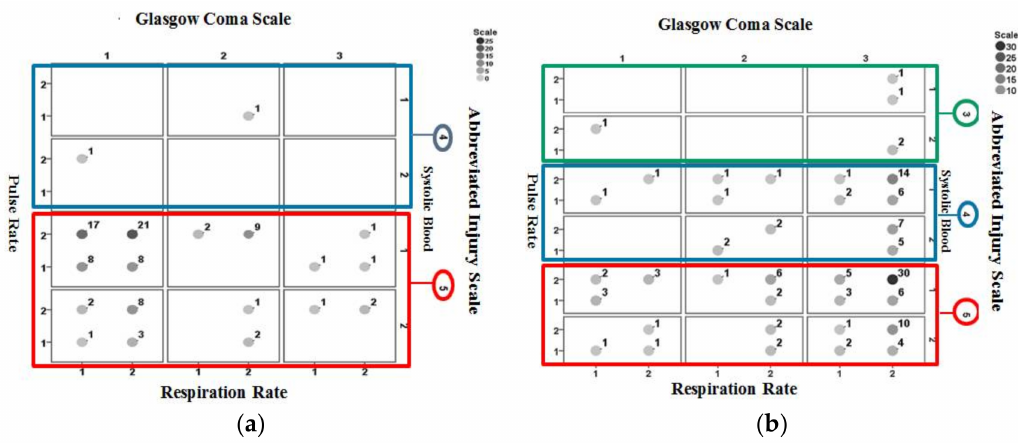
Figure 7. Identification results for Ps14 for non-surviving cases in the validation dataset: ( a ) correctly identified cases ( b ) misidentified cases. The values next to the circles indicate the number of associated